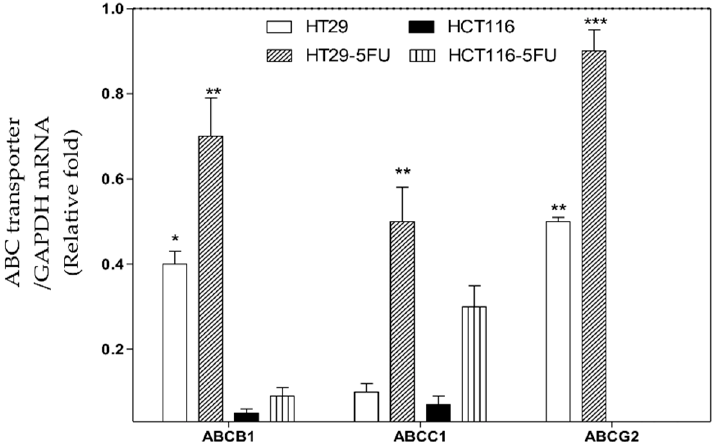
Figure 5. Total mRNA was isolated from HT29, HT29-5FU, HCT116, and HCT116-5FU cells and quantified by RT-PCR with ABCB1, ABCC1, and ABCG2 primers. The results were expressed as relative fold change (average ± SD, n = 3, × 2 independent experiments) compared with GAPDH (1-fold change). Statistical differences (one-way ANOVA, Tukey’s post-hoc): p < 0.05 (*), p < 0.01 (**), and p < 0.001 (***) were considered significant.